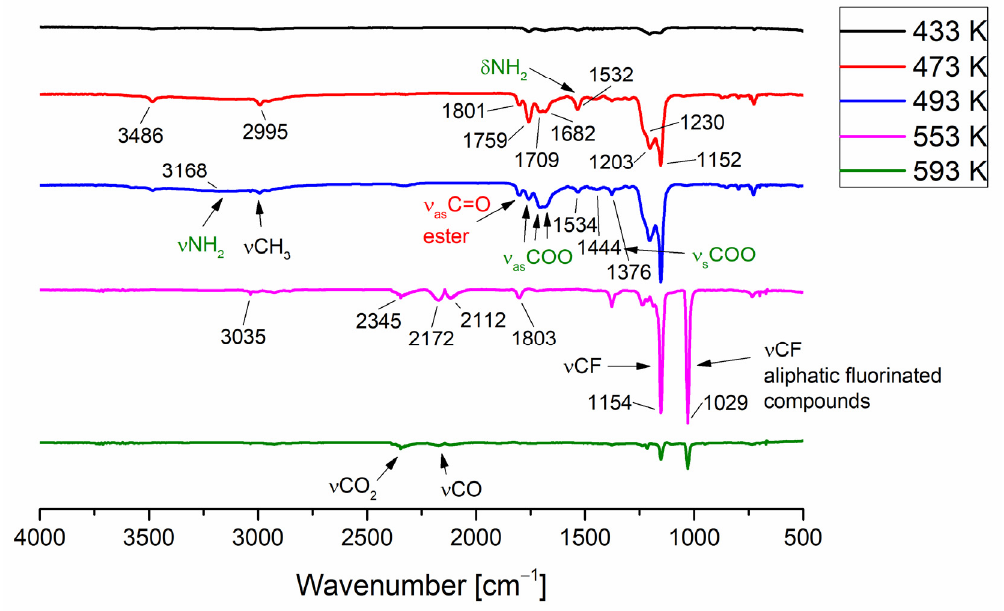
Figure 4. Temperature variable infrared spectra VT IR for the vapour formed during the [Cu 2 (EtNH 2 ) 2 (µ-O 2 CCF 3 ) 4 ] complex ( 1 ) heating.